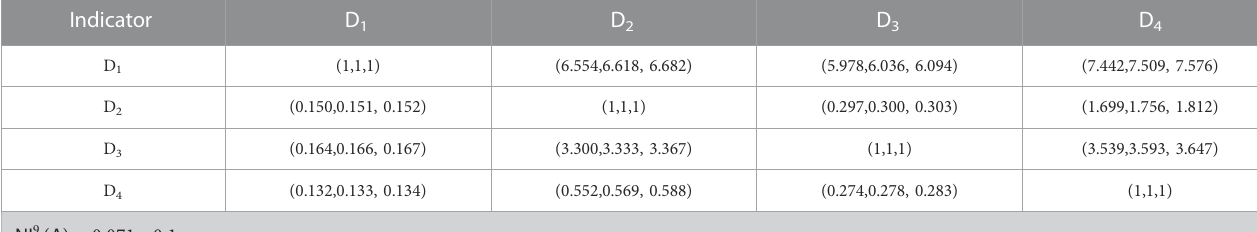
TABLE 8 Pairwise comparison matrix of factor layer of commissioning and acceptance of power supply department (MCS-AHP). Indicator